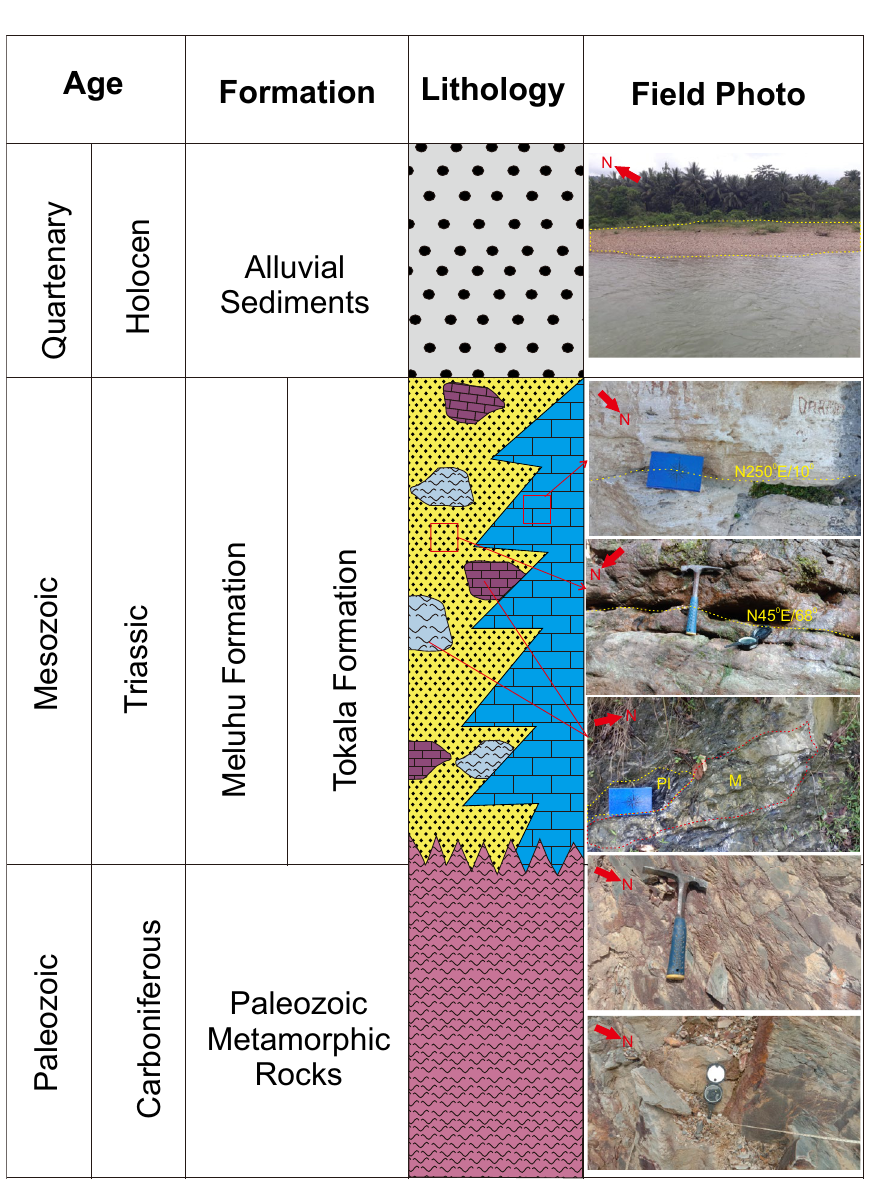
Fig. 11 Stratigraphic column of the study